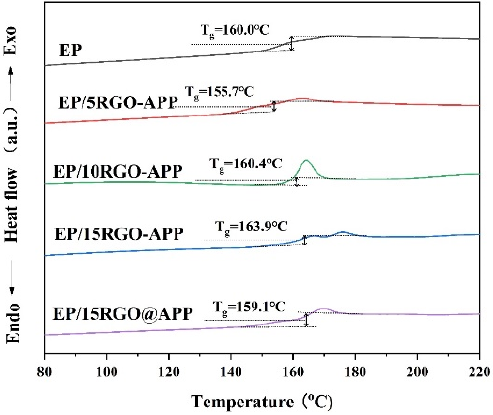
Figure 6. Differential scanning calorimeter (DSC) curves of pure EP and flame-retardant EP.